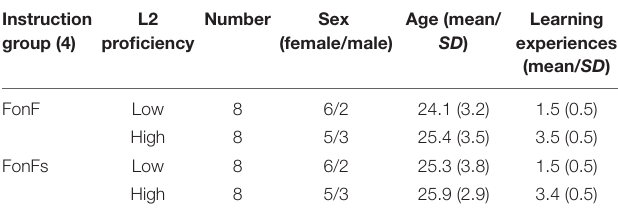
TABLE 1 | Biographical and proficiency characteristics of the L2 Chinese